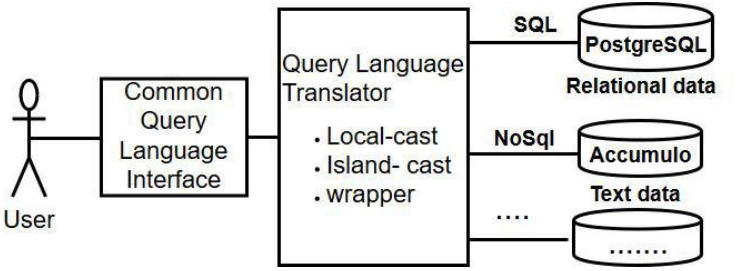
Figure 1. Bottom-up design of a Polystore